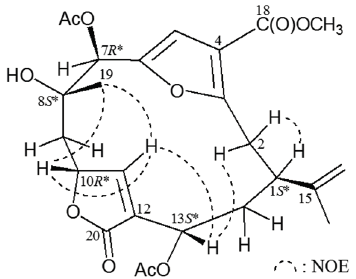
Figure 3. NOESY ( nuclear overhauser effect spectroscopy ) correlations of compound 4 .